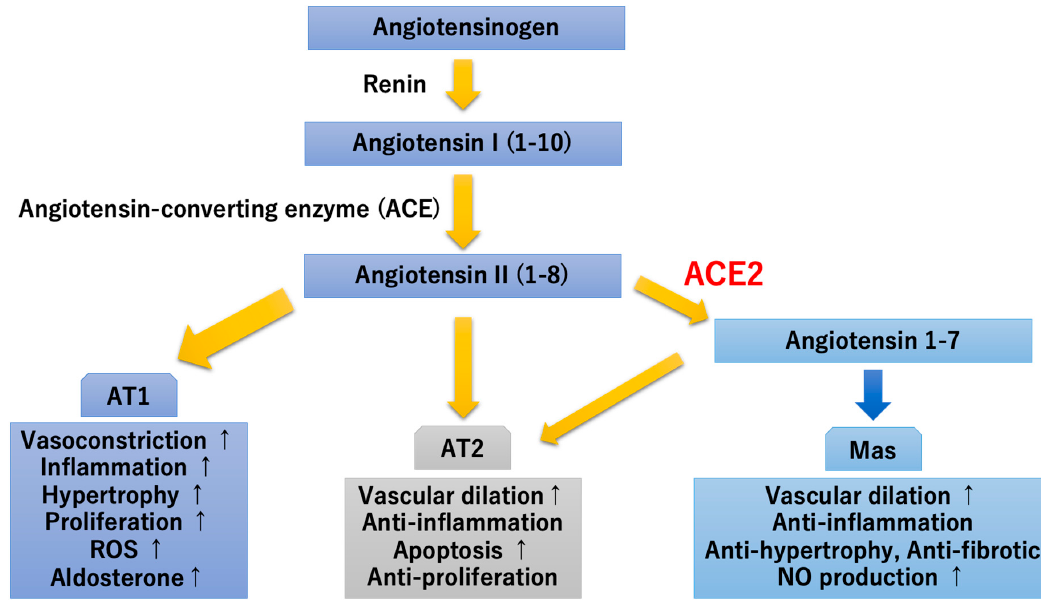
Figure 3. Renin-angiotensin system and angiotensin-converting enzyme 2 (ACE2). ACE2 was identified as an enzyme that degrades angiotensin II to angiotensin 1–7, which binds to the